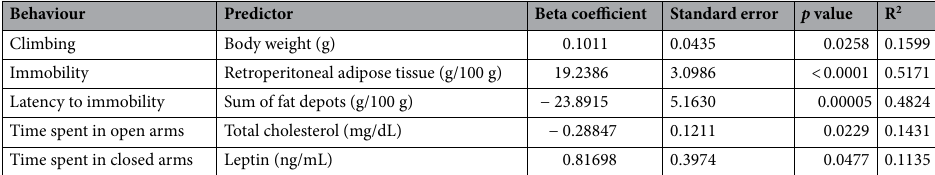
Table 3. Linear regression models for anxious- and depressive-like behaviours as dependent